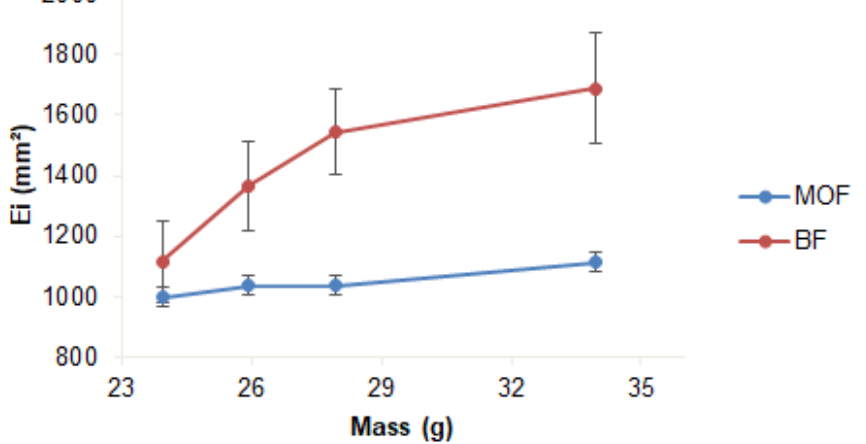
Figure 2. Spreadability of cosmeceutical formulations: base (BF) and with microcapsules of coffee oil (MOF). Triplicate mean; error bars: standard deviation.